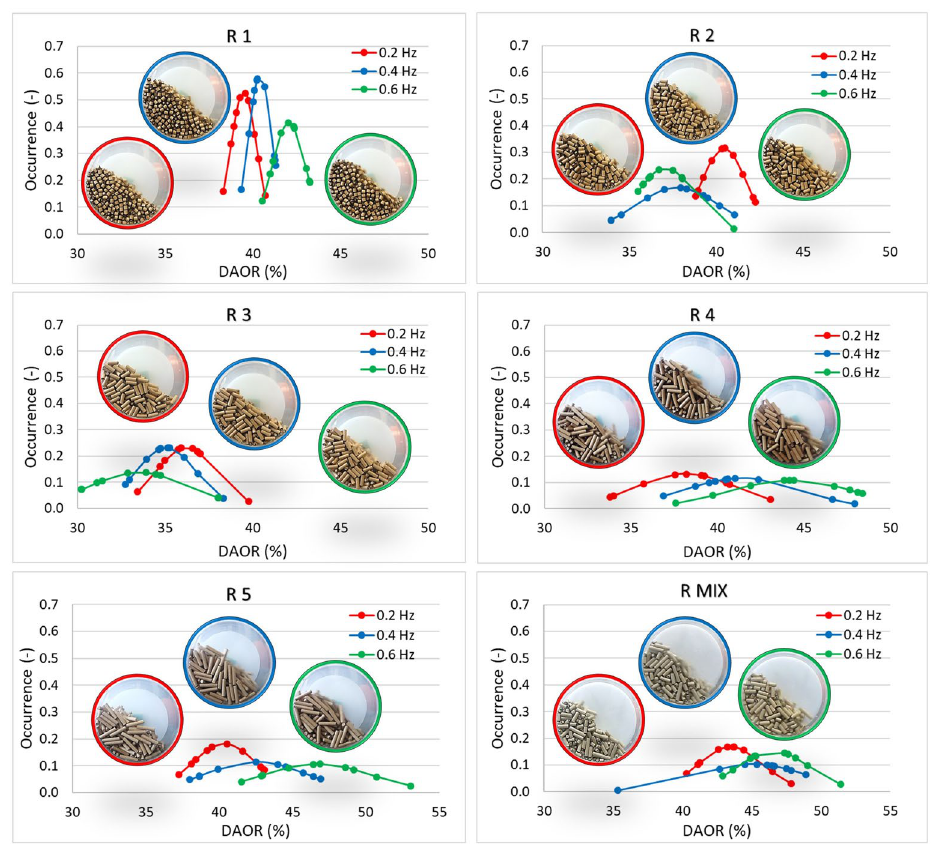
Figure 17. Dynamic angle of repose (DAOR) for